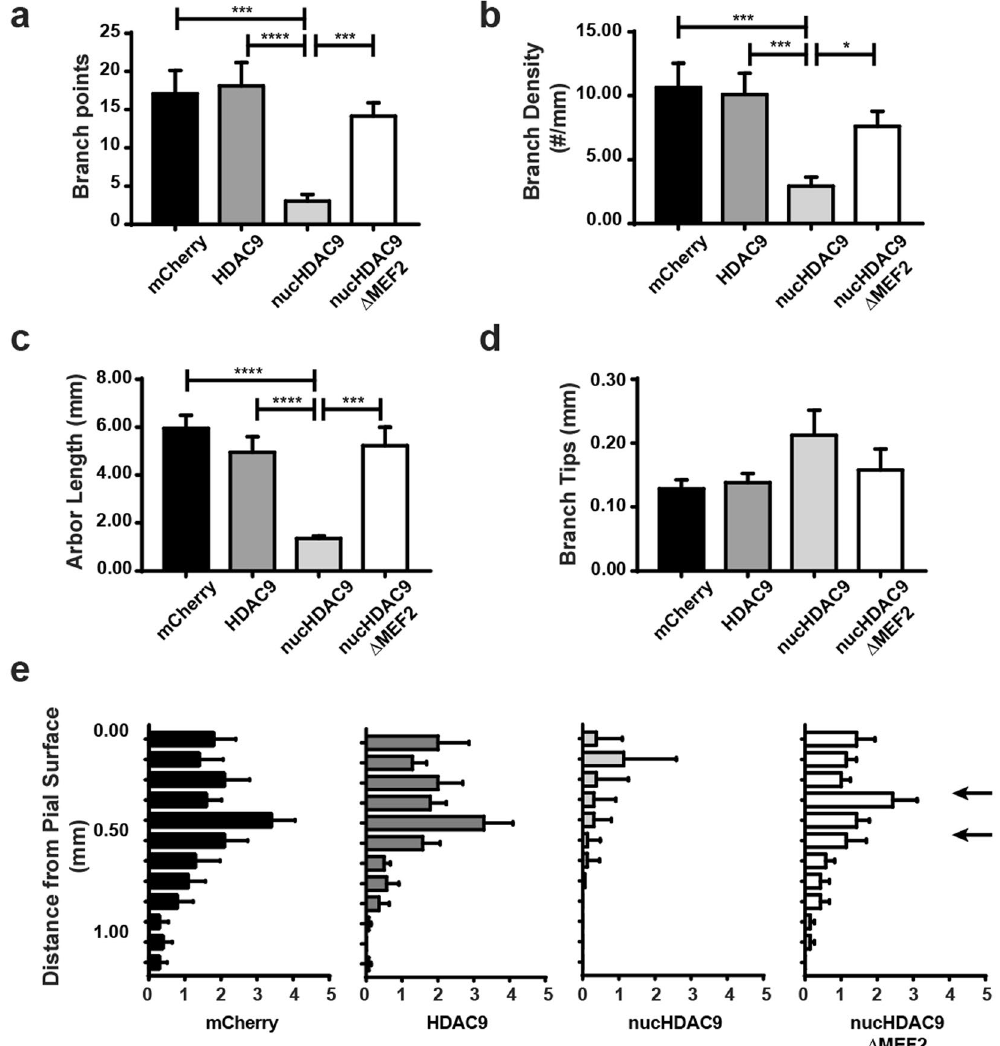
Figure 5. Nucleocytoplasmic translocation of HDAC9 is required for TC axon branching via MEF2 regulation. ( a ) Average number of branch points per axon. Thalamic cells were electroporated with only mCherry, HDAC9 co-electroporated with mCherry, nucHDAC9 co-electroporated with mCherry, and nucHDAC9 Δ MEF2 co- electroporated with mCherry. N = 12, 17, 18 and 14 axons from 4–6 co-cultures for each condition, respectively. ( b ) Branch density per axon. ( c ) Total branch length per axon. ( d ) Branch tip length. Statistical analysis by Kruskal-Wallis test with Dunn correction comparing the 4 columns. * p < 0.05. *** p < 0.001. **** p < 0.0001. e. Laminar distribution of branching points according to their distance from the pial surface. Arrows indicate presumed layer 4. Statistical analysis by two-way ANOVA for whole column effects with Tukey’s multiple comparisons test confirmed a significant difference in laminar specificity between nucHDAC9 and control (p < 0.0001), while no significant difference was found between nucHDAC9 Δ MEF2 and control or wild-type